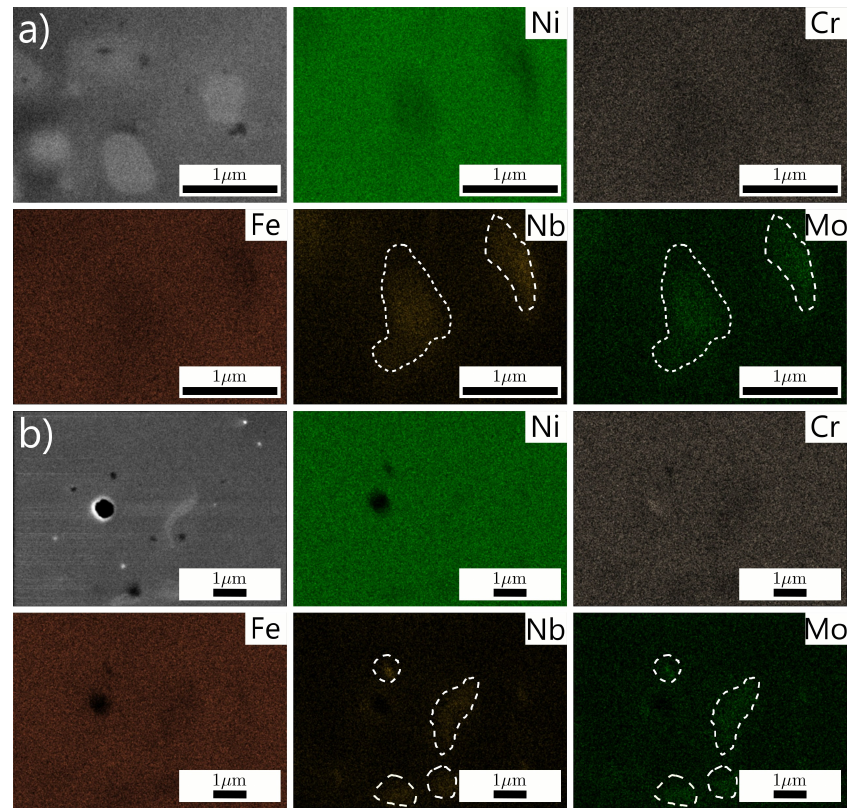
Figure 10. Elemental distribution maps of AM Inconel 718 samples under no ( a ) and superimposed ( b ) vertical MF conditions. Table 4. Energy-dispersive X-ray elemental analysis (EDX) and nitrogen, oxygen, and hydrogen content for AM Inconel 718 samples under no and superimposed MF. Element content,